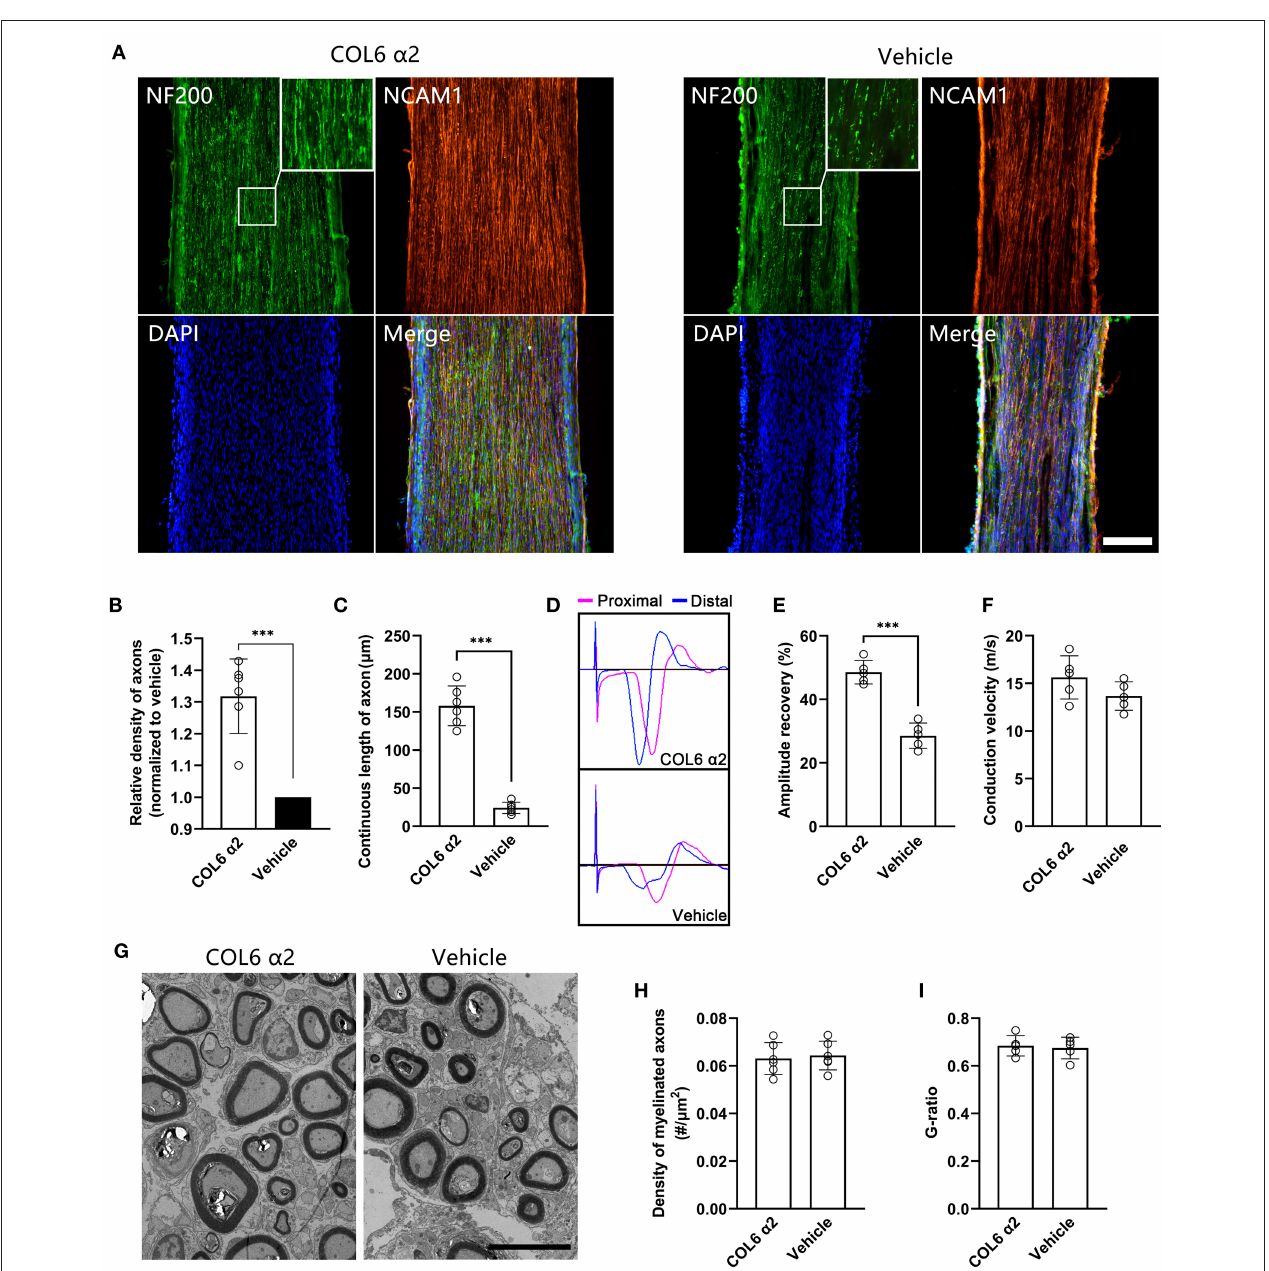
FIGURE 5 | Addition of COL6 α 2 in Matrigel improves the regeneration of sciatic nerve defect. Based on a rat sciatic nerve defect model, the nerve stumps were bridged with a catheter filled with 10 mg/ml Matrigel as the carrier. 20 µ g/ml COL6 α 2 and an equal volume of saline were added to the Matrigel in the COL6 α 2 and vehicle groups, respectively. (A) After 8 weeks of repair, the longitudinal sections with immunofluorescence staining showed regenerated nerve tissues from the COL6 α 2 and vehicle groups. (B) Histogram showing an increased density of axons in the COL6 α 2 group compared to the vehicle group ( n = 6 animals, *** p = 0.0009, ratio paired t- test, normalized to vehicle). (C) The continuous length of axons was measured and compared between the two groups ( n = 6 animals, *** p < 0.0001, unpaired t- test). (D) Panels showing representative traces of CMAP in the COL6 α 2 and vehicle groups (magenta trace, the stimulating electrode was placed at the proximal of the nerve trunk; blue trace, the stimulating electrode was placed distal to the nerve trunk). (E) Histogram showing the amplitude recovery of the injured sciatic nerve in the COL6 α 2 and vehicle groups ( n = 5, *** p < 0.0001, unpaired t- test). (F) Histogram showing the motor nerve conduction velocities of the COL6 α 2 and vehicle groups; no statistical difference was detected between the two groups ( n = 5, p = 0.1449, unpaired t- test). (G) Representative TEM images of sciatic nerve cross-sections showing myelinated axons after 8 weeks of regeneration. (H) Histogram showing the density of myelinated axons in the COL6 α 2 and vehicle groups ( n = 6 visual fields from three animals, p = 0.7378, unpaired t- test). (I) The degree of myelination was evaluated between groups using the axon-to-fiber diameter ratio (G-ratio; n = 5 visual fields, p = 0.7442, unpaired t- test). Scale bars = 200 µ m in (A) and 5 µ m in (G) .